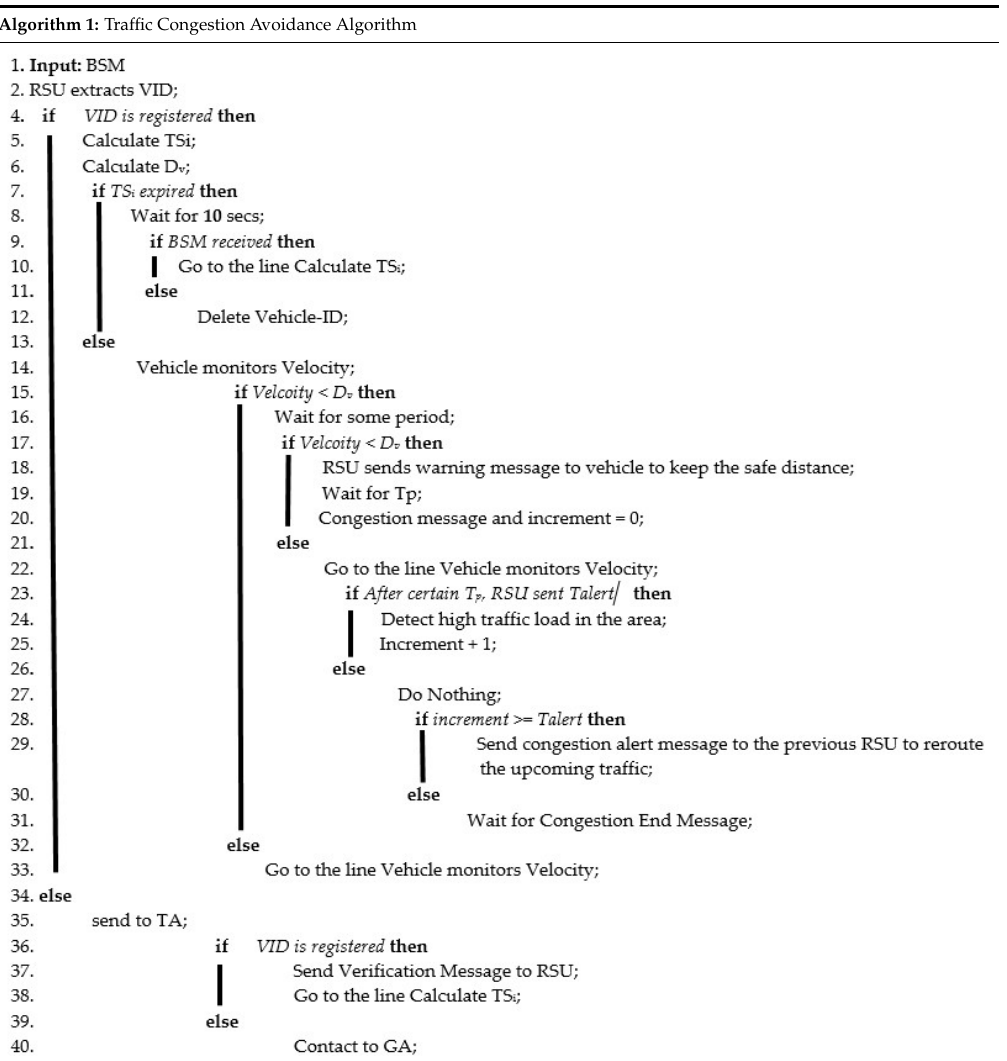
Algorithm 1: Traffic Congestion Avoidance Algorithm